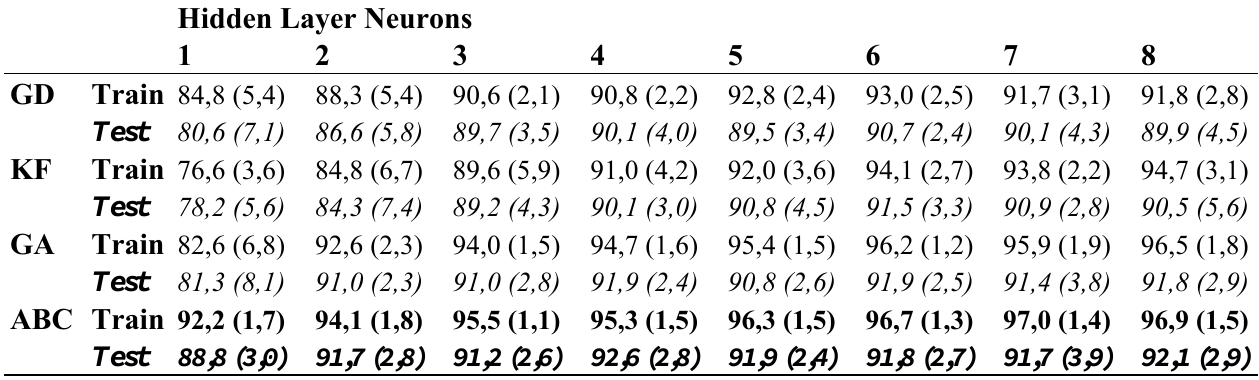
Table 6. Statistical PCCS results of Glass